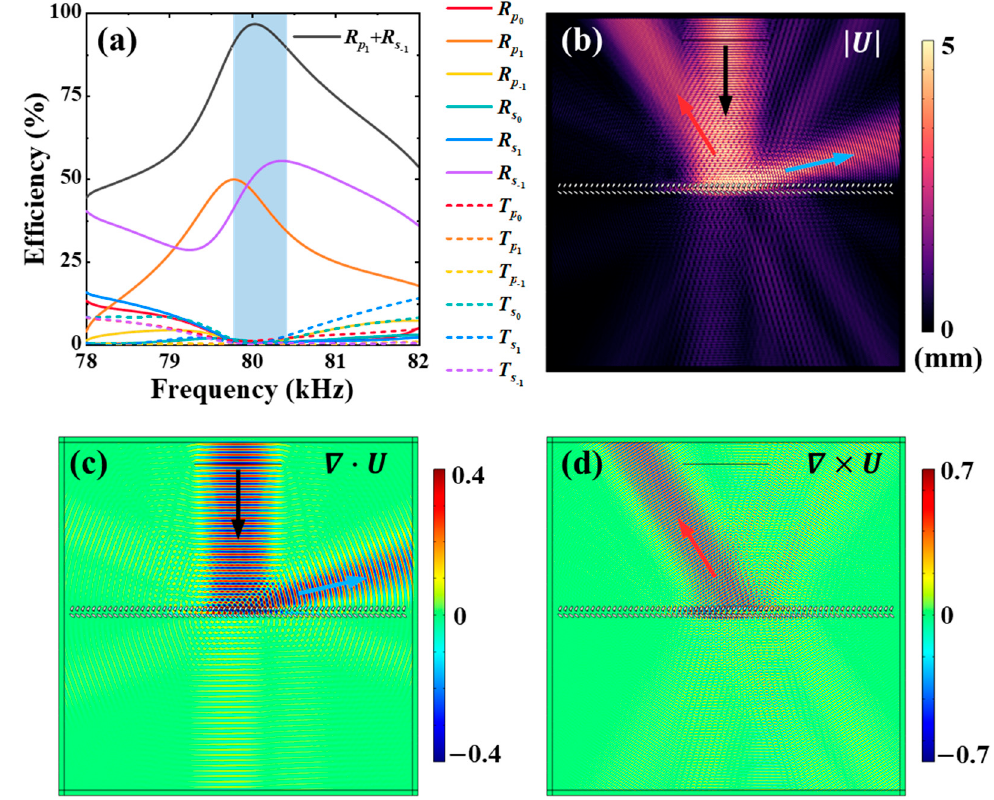
Figure 4. High-efficiency reflection along the R p and R s channels when a p -wave is normally incident on the metagrating. ( a ) The diffraction efficiency spectra for all 12 channels, where f 0 = 80 kHz is the operating frequency; ( b ) shows the amplitude of displacement amplitude at f 0 ; ( c , d ) show the divergence and curl of the displacement field, corresponding to longitudinal and transverse wave components, respectively. Black, blue and red arrows represent the incident p -wave, reflected p -wave, and reflected s -wave, respectively.